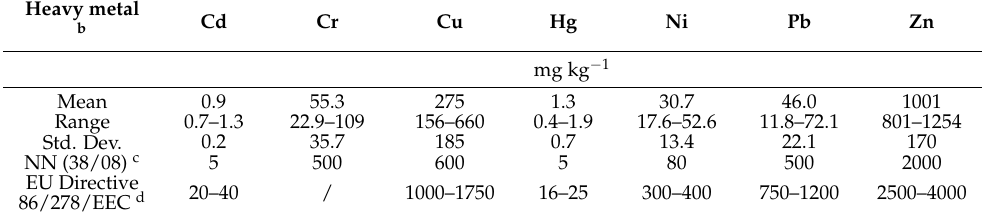
Table 7. Mean, range, and variability of heavy metals concentration a in stabilized sewage sludge collected from different Croatian wastewater